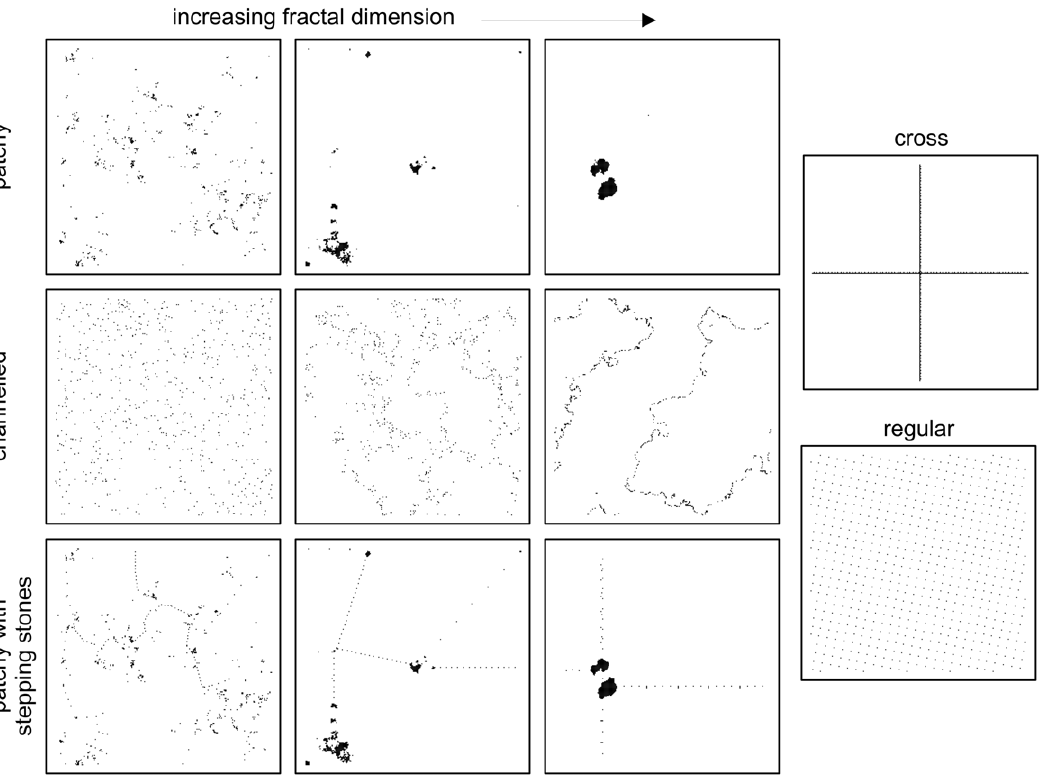
Figure 1. Examples of the landscape patterns used for simulations of range advance. Nine example landscapes generated from fractals are shown, along with the idealized ‘‘regular’’ and ‘‘cross’’ landscapes. All landscapes have the same overall amount of habitat: 1%. In total we used 10 randomly generated fractals for each of 11 levels of fractal dimension. The patchy landscapes consist of clusters of varying sizes, reminiscent of the pattern of many fragmented natural habitats. The channeled landscapes are the negative image of the patchy landscapes (i.e. they are the gaps left between clusters of non-habitat). Similar patterns may exist in nature for habitats associated with rivers or with ecotones. The patchy landscapes with stepping stones represent the kind of pattern that could be achieved with deliberate habitat re-creation (0.9% pre-existing patches and 0.1% stepping stones along the multiple shortest paths, see methods).